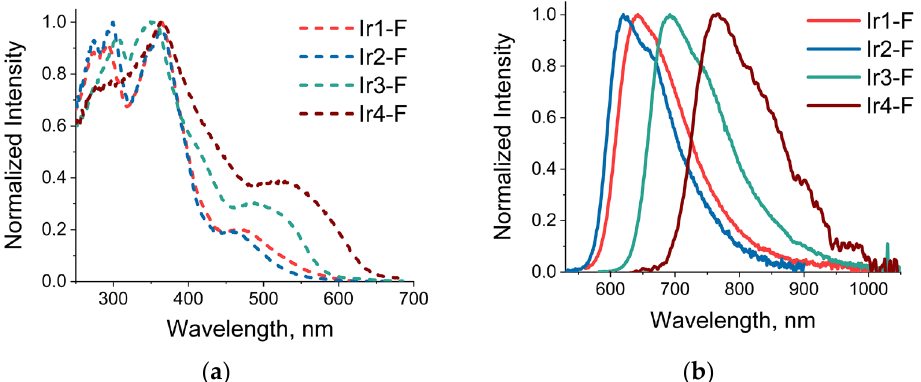
Figure 5. Normalized excitation ( a ) and emission spectra ( b ) of complexes Ir1-F, Ir2-F, Ir3-F, Ir4-F.